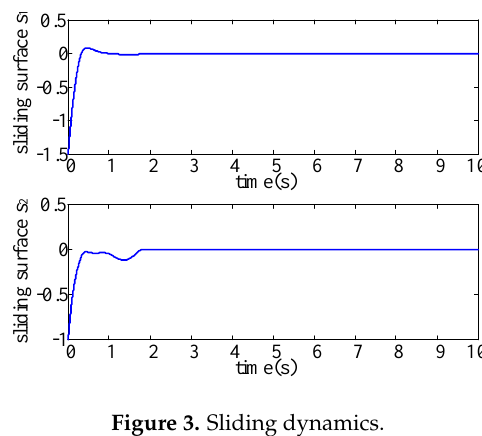
Figure 3. Sliding dynamics.